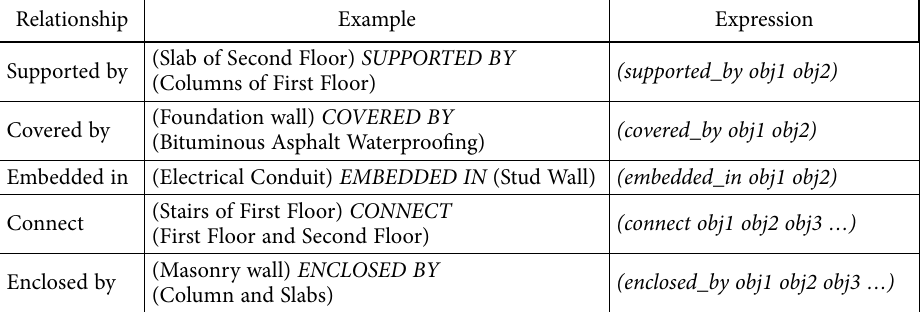
Table 1. Selected examples of topological relationships Relationship Example